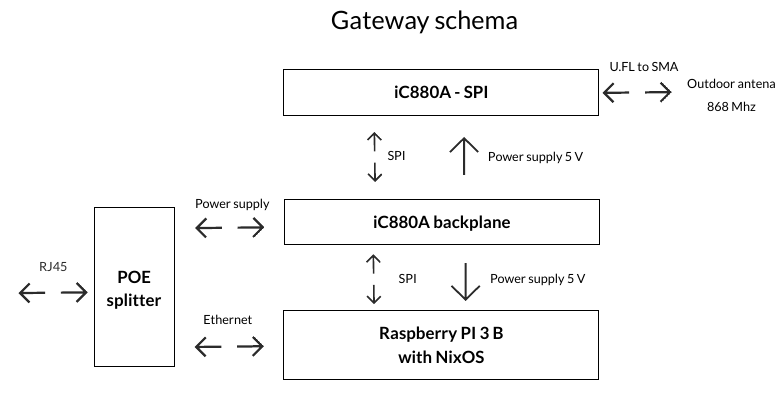
Figure 8. Gateway schema based on Raspberry PI and ICC880A.